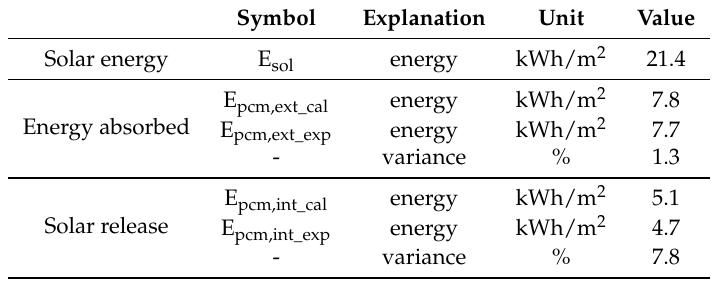
Table 3. Comparison of thermal energy results from calculation and experimental methods.